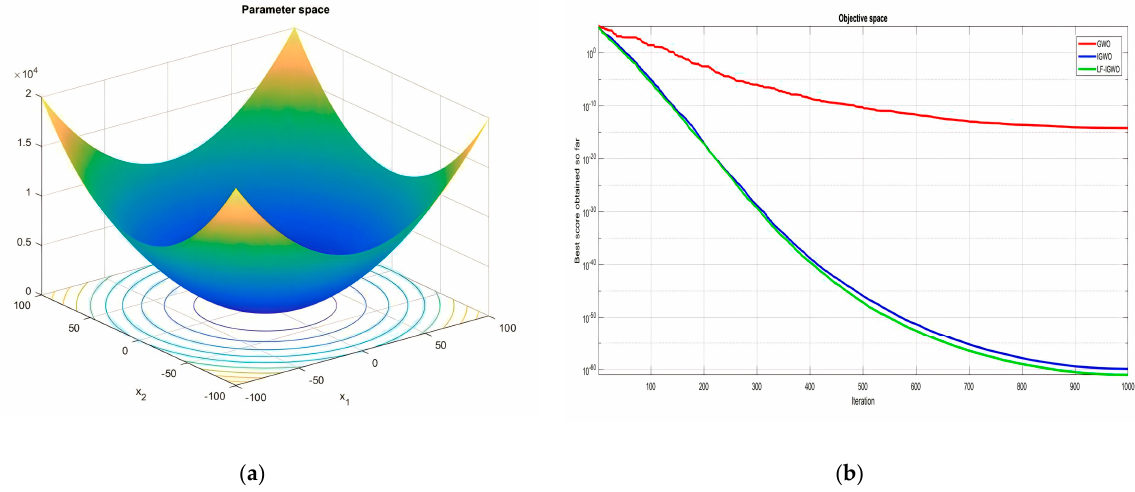
Figure 3. ( a ) Search space for unimodel function F01 ( b ) Comparison of convergence curve for F01.